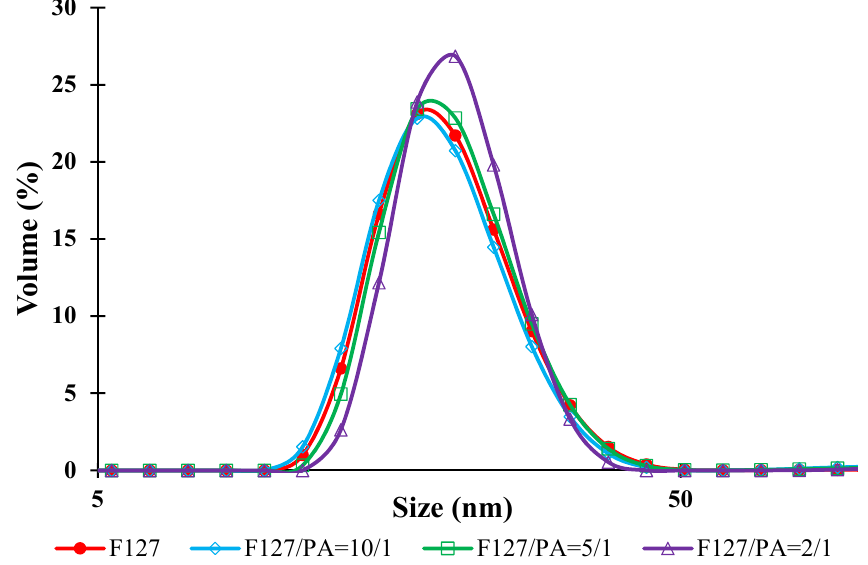
Figure 2. Size distribution curves in volume for free and API-loaded PMs at 37 °C.